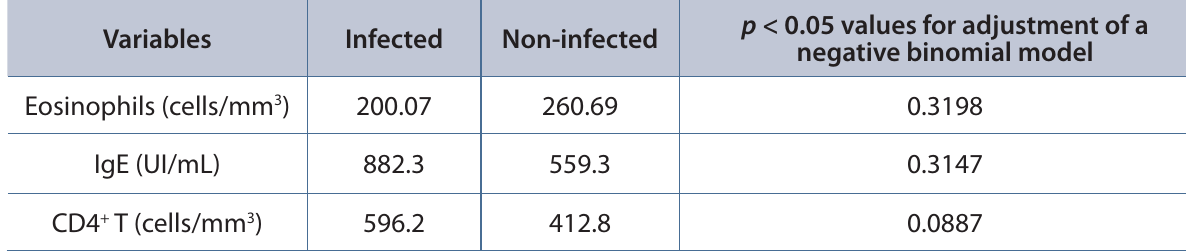
Table 2. Mean eosinophil, IgE, and CD4+ T cell levels according to intestinal parasitic infections in 105 HIV/AIDS individuals treated at the Specialized Outpatient Service and Day Hospital Professor Emeritus Domingos Alves Meira, UNESP, 2007-2008. The p values obtained by adjusting a negative binomial model were 0.3198, 0.3147, and 0.0887, respectively